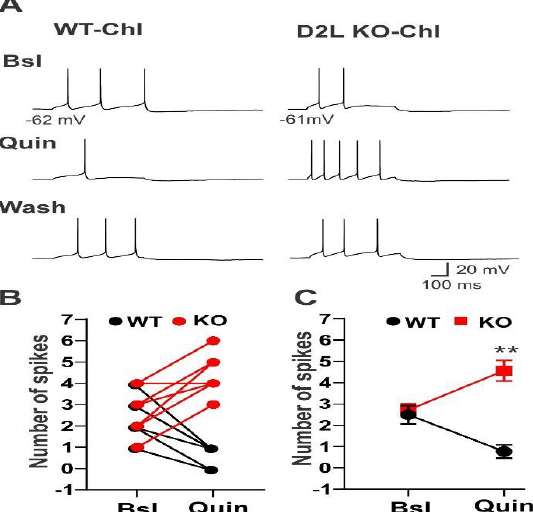
Figure 1. Quinpirole increased the excitability of ChIs in D2L KO mice. ( A ) Baseline (Bsl) spikes were induced by injecting depolarizing currents in ChIs from WT and D2L KO mice (top traces). Quinpirole (Quin) significantly decreased the firing rate in ChIs from WT mice (left middle trace), but significantly increased the firing rate in ChIs from D2L KO mice (right middle trace). Wash: spikes were recorded after washing off quin (bottom traces). ( B ) Summary of quinpirole effects on spike firing of ChIs from WT mice (filled black circles, n = 6) and from D2L KO mice (filled red circles, n = 7). The spike numbers of individual cells were plotted versus Bsl (without quin) or in the presence of Quin. ( C ) The mean spike numbers of cells were plotted versus Bsl or Quin. ** p < 0.003 (WT); ** p < 0.006 (D2L KO; Student’s t -test). Note that some lines are overlapped in Figures 1B, 2B and 3B.